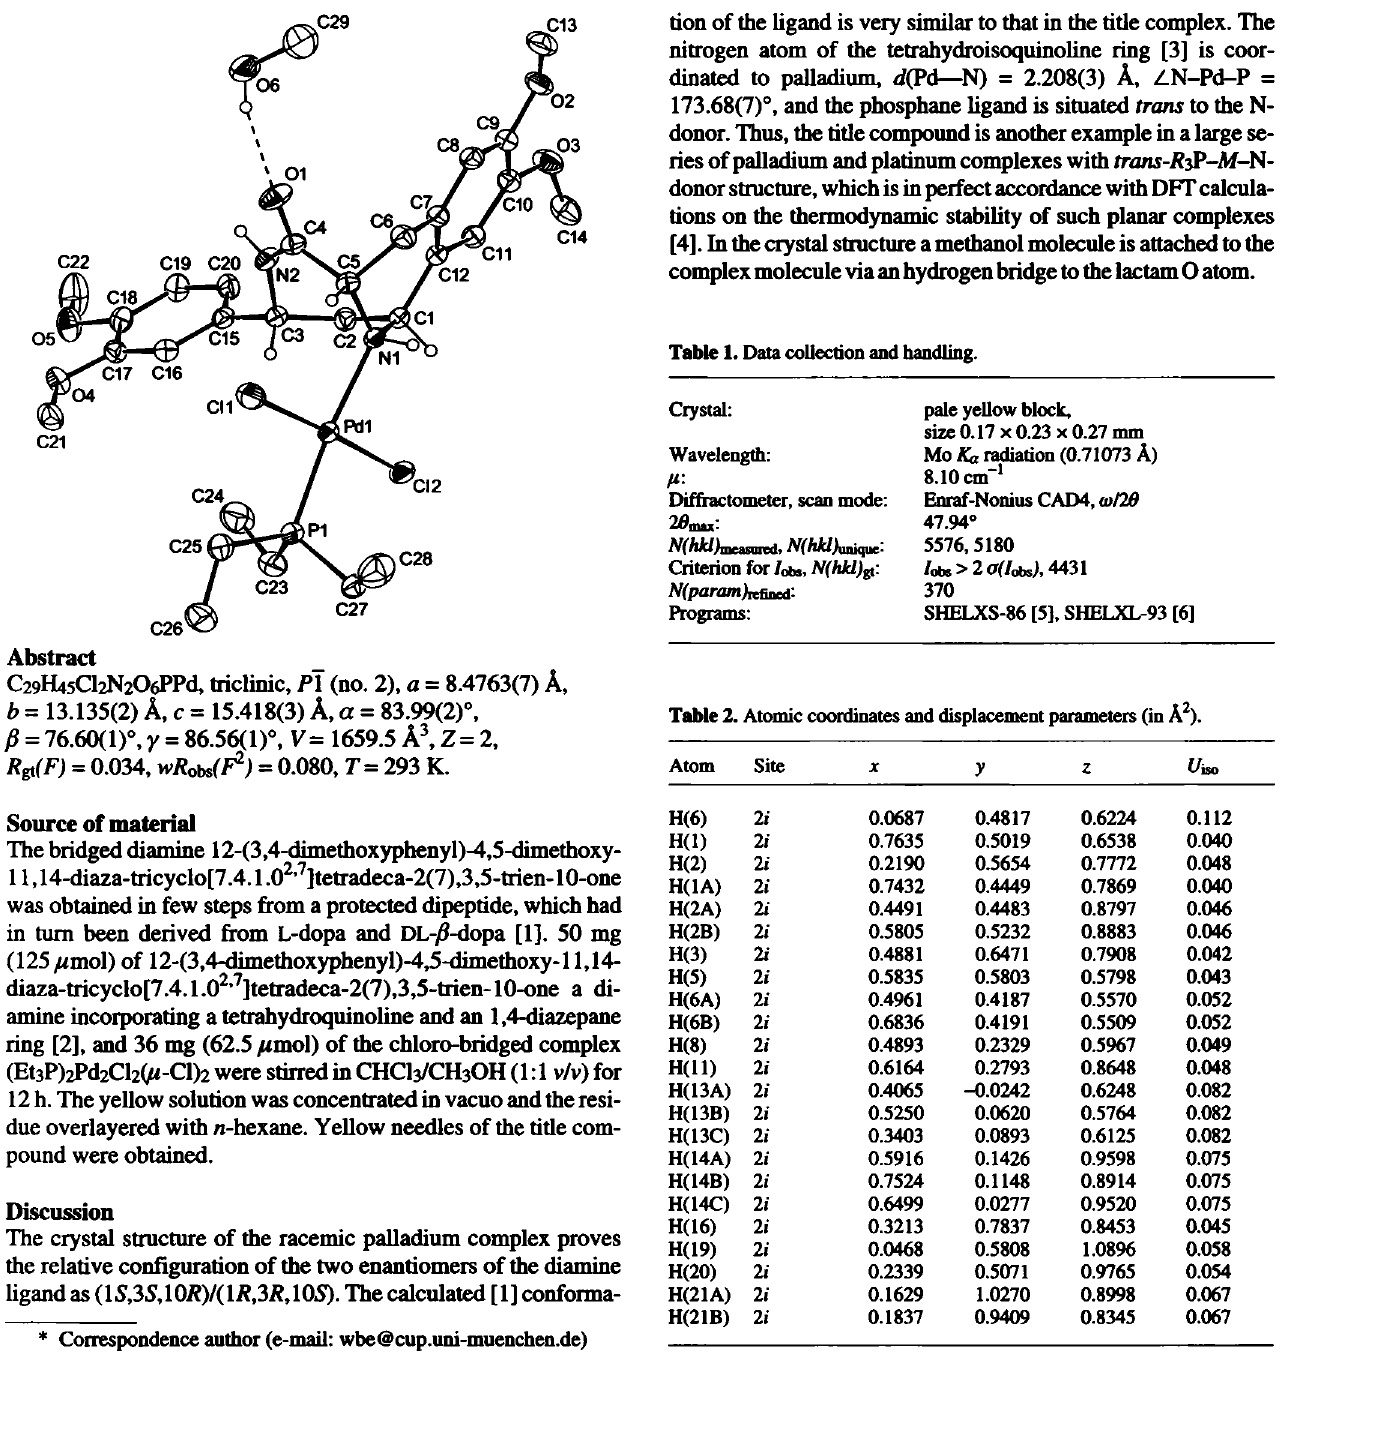
Table 2. Atomic coordinates and displacement parameters (in A 2